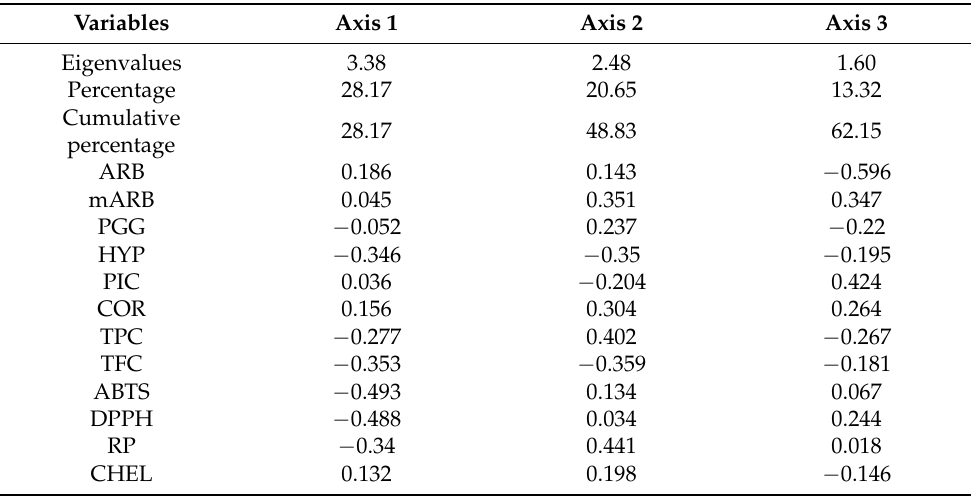
Table 3. Results of PCA based on the chemical composition of bearberry leaf extracts and antioxidant activity parameters.